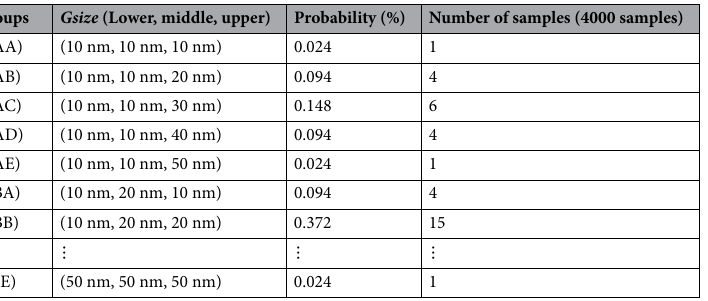
Table 3. The G size of several cases in the 3-D stacked ADG 1 T-DRAM of the proposed GB model: from the group (AAA) to (EEE). A, B, C, D, and E means G size is 10 nm, 20 nm, 30 nm, 40 nm, and 50 nm, respectively. The number of sample values is the probability multiplied by the 4000 and rounded up.